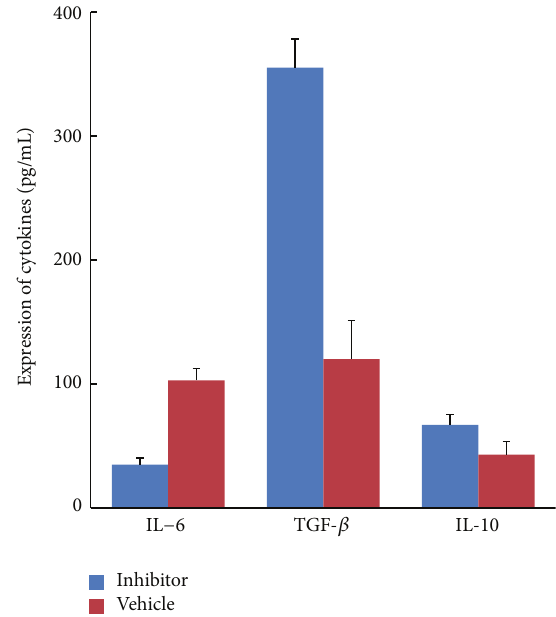
Figure 5: The cPLA 2 inhibitor AX059 increased the expression of TGF- 𝛽 and IL-10 and downregulated the expression of IL-6 in the rats’ spleen